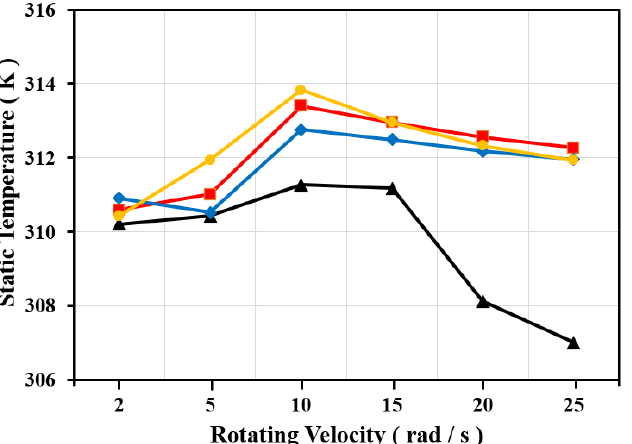
Figure 9. Variations in mixing temperature with respect to wall rotation velocity. Black, inner wall rotation; red, outer wall rotation; blue, inner–outer clockwise rotation; yellow, inner–outer counterclockwise